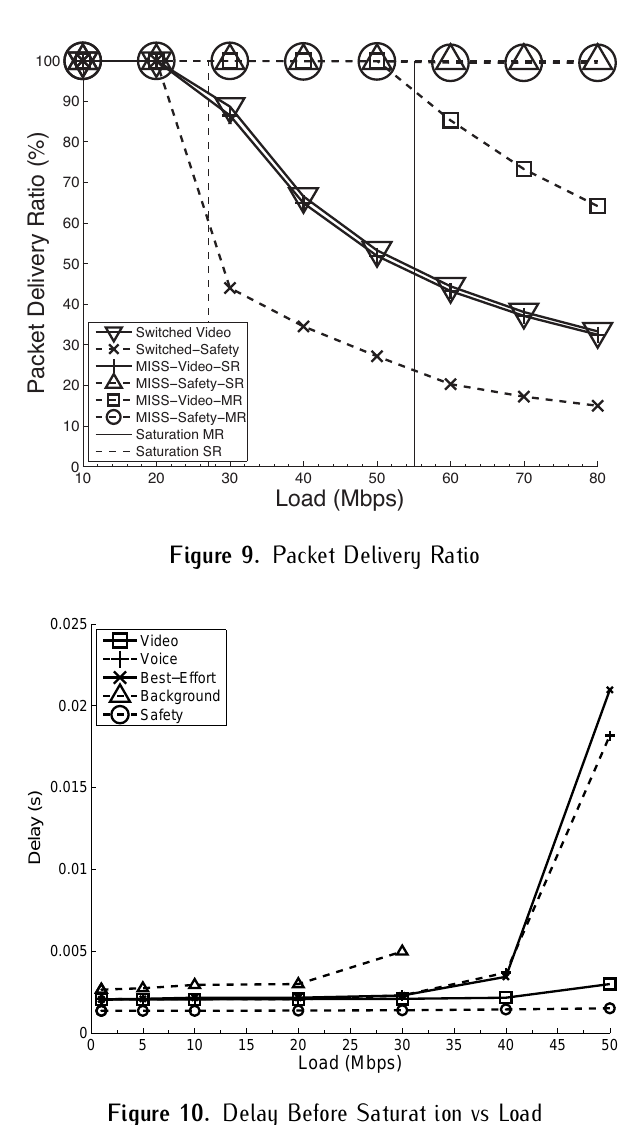
Figure 10. Delay Before Saturat ion vs